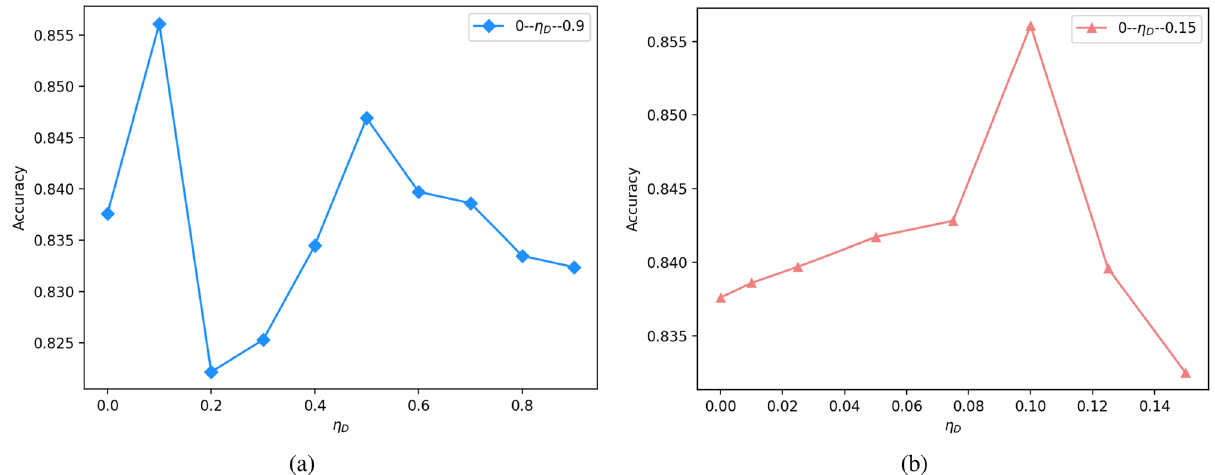
Figure 5. Hyperparameter study. For all η D values, the source domain is virus. Accuracy is reported as the average result over 3 runs with random